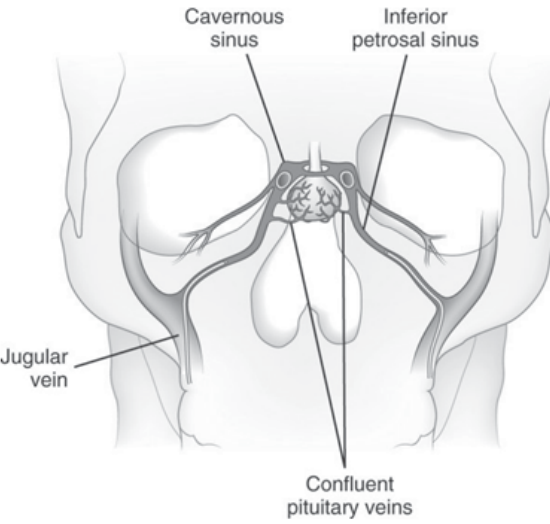
Figure 1. Anatomy of the venous drainage of the pituitary gland (2)